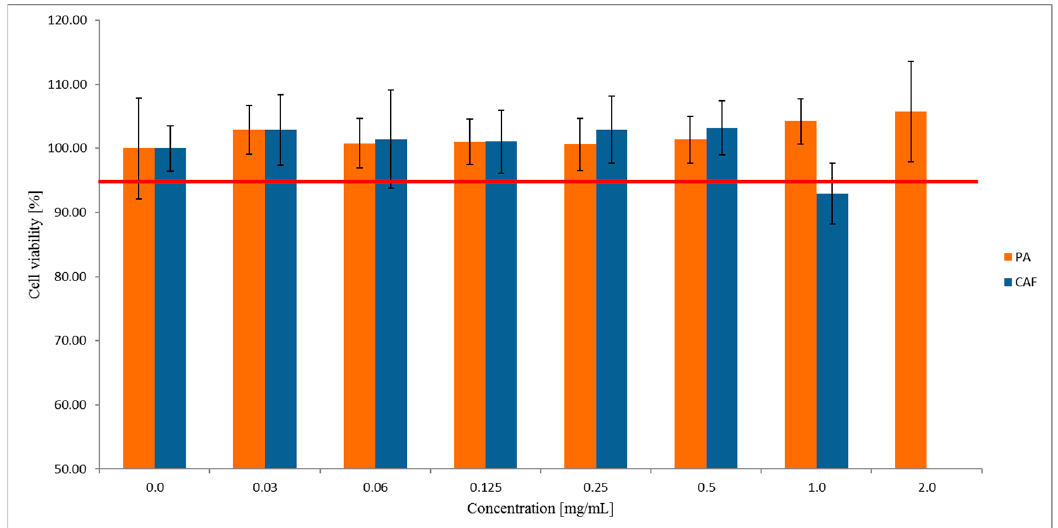
Figure 1. The viability of the Caco-2 cell line treated with PA and CAF. Results of the three independent replicates are presented as the mean ± SD. Acceptance criterion for the cell viability exposed for different compounds concentration has been established as 95% (red line).